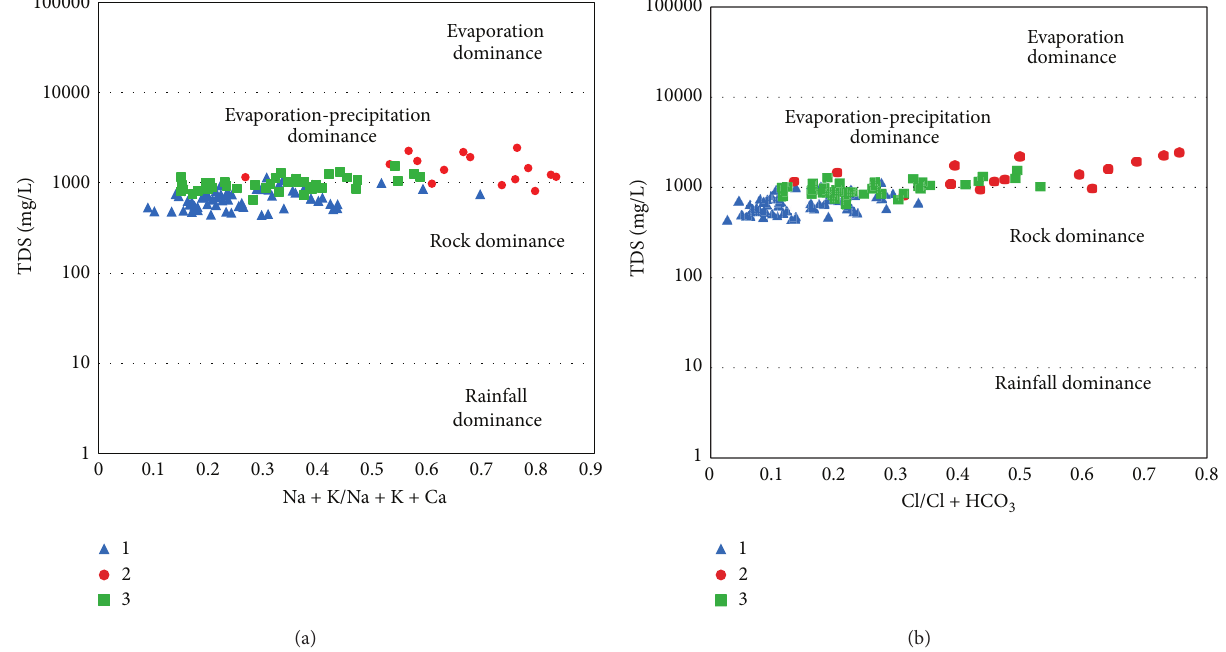
evaporation was the dominant process in addition to the chloride on the east and north-eastern sides of the study area. Based on the hierarchical cluster analysis of sampling wells, samples of the first and third classes, which were distributed on the west, south, and central sides, represent the fresh- water type. The Gibbs plot indicated that the hydrochemistry of these groups were mainly influenced by the rock domi- nance, including carbonate and silicate rocks weathering. The groundwater type of second class gradually changed to saline water towards the north-eastern side of the plain. The Gibbs diagram clearly displayed the role of the evaporation process in the groundwater chemistry of the second group. The groundwater samples were saturated with respect to calcite and dolomite in all three groups, and were under saturated with respect to halite and gypsum minerals. Special manage- ment could be suggested for the salinity control in the areas with saline water, which were specified by spatial distribution maps in the ArcGIS